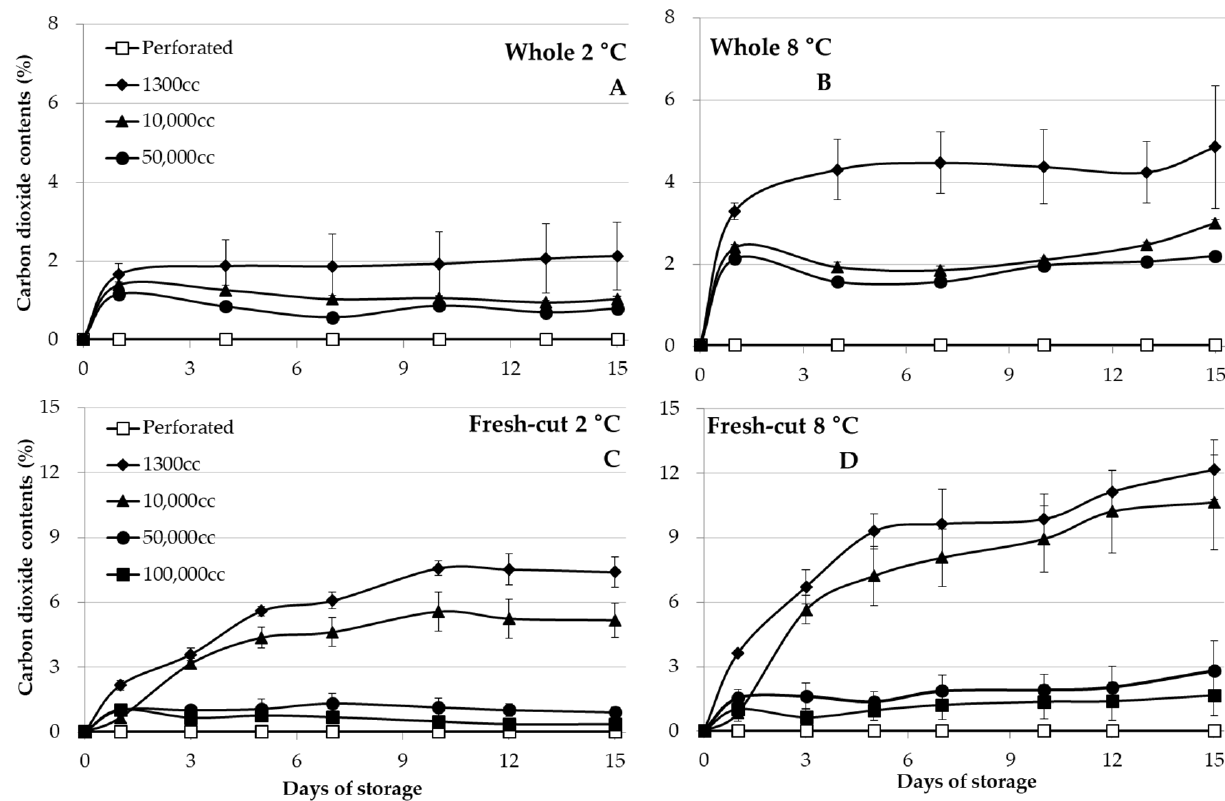
Figure 2. The carbon dioxide contents of whole ( A : 2 ◦ C and B : 8 ◦ C) and fresh-cut ( C : 2 ◦ C and D : 8 ◦ C) romaine lettuce in OTR film (1300 cc; 10,000 cc; 50,000 cc; 100,000 cc · m − 2 · day − 1 · atm − 1 ) in MA storage at 2 and 8 ◦ C for 15 days. Vertical bars represent ± SD of the means ( n = 5).